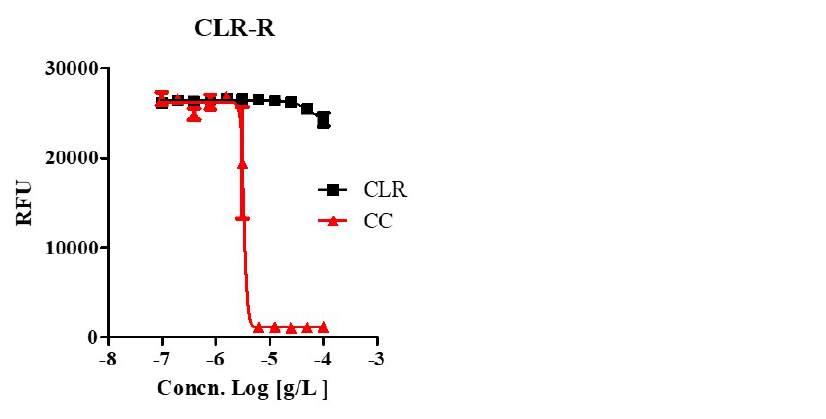
Figure 4. Dose-response curves of CC. Dose-response curves of M. abscessus under aerobic, anaerobic, and biofilm condi- tions using resazurin. CLR was used as a reference control. ( A ) aerobic condition, M. abscessus was cultured until the mid- log phase, taking approximately 24 h. ( B ) anaerobic condition, M. abscessus was undergone for seven days within an an- aerobic generating container system (BD GasPak™EZ). ( C ) Biofilm, M. abscessus was examined with Calgary Biofilm De- vice. The experiments were carried out with three biological replicates and expressed as the mean ± SEM for each concen- tration. This result was made from a representative experiment.